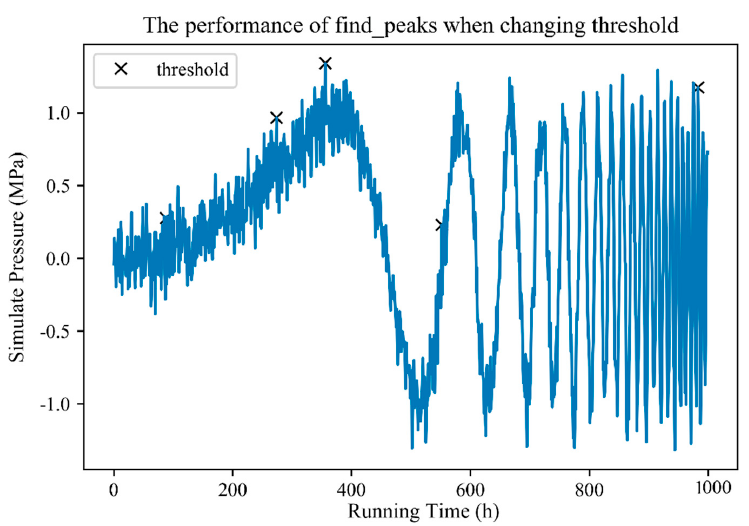
Figure 5. Diagram of the threshold-based wave detection algorithm to capture peaks in pressure changes.